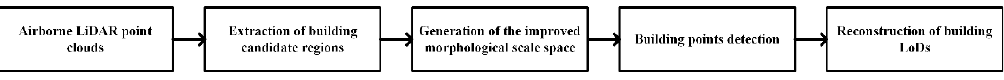
Figure 5. Flowchart of generating building LoDs from Airborne LiDAR point clouds.